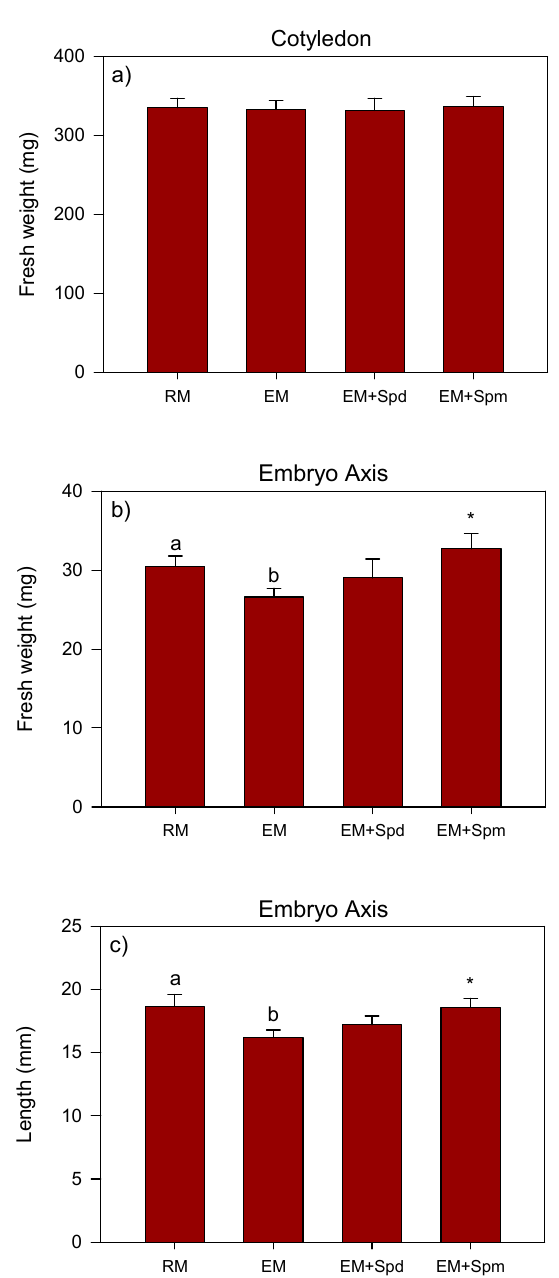
Figure 2. Fresh weight and length of the 4 DAP seedling tissues. Fresh weight (mg) of the cotyledon ( a ) and embryo axis ( b ), and length (mm) of the embryo axis ( c ) under regular watering (RM) and excess moisture (EM) conditions, with or without seed treatment with spermidine (EM + Spd) or spermine (EM + Spm). Data are the means ± SE, n = 12 to 15. Different letters indicate significant differences between the RM and EM while asterisks (*) indicate significant differences between the EM and EM + Spd or EM + Spm, p ≤ 0.05.